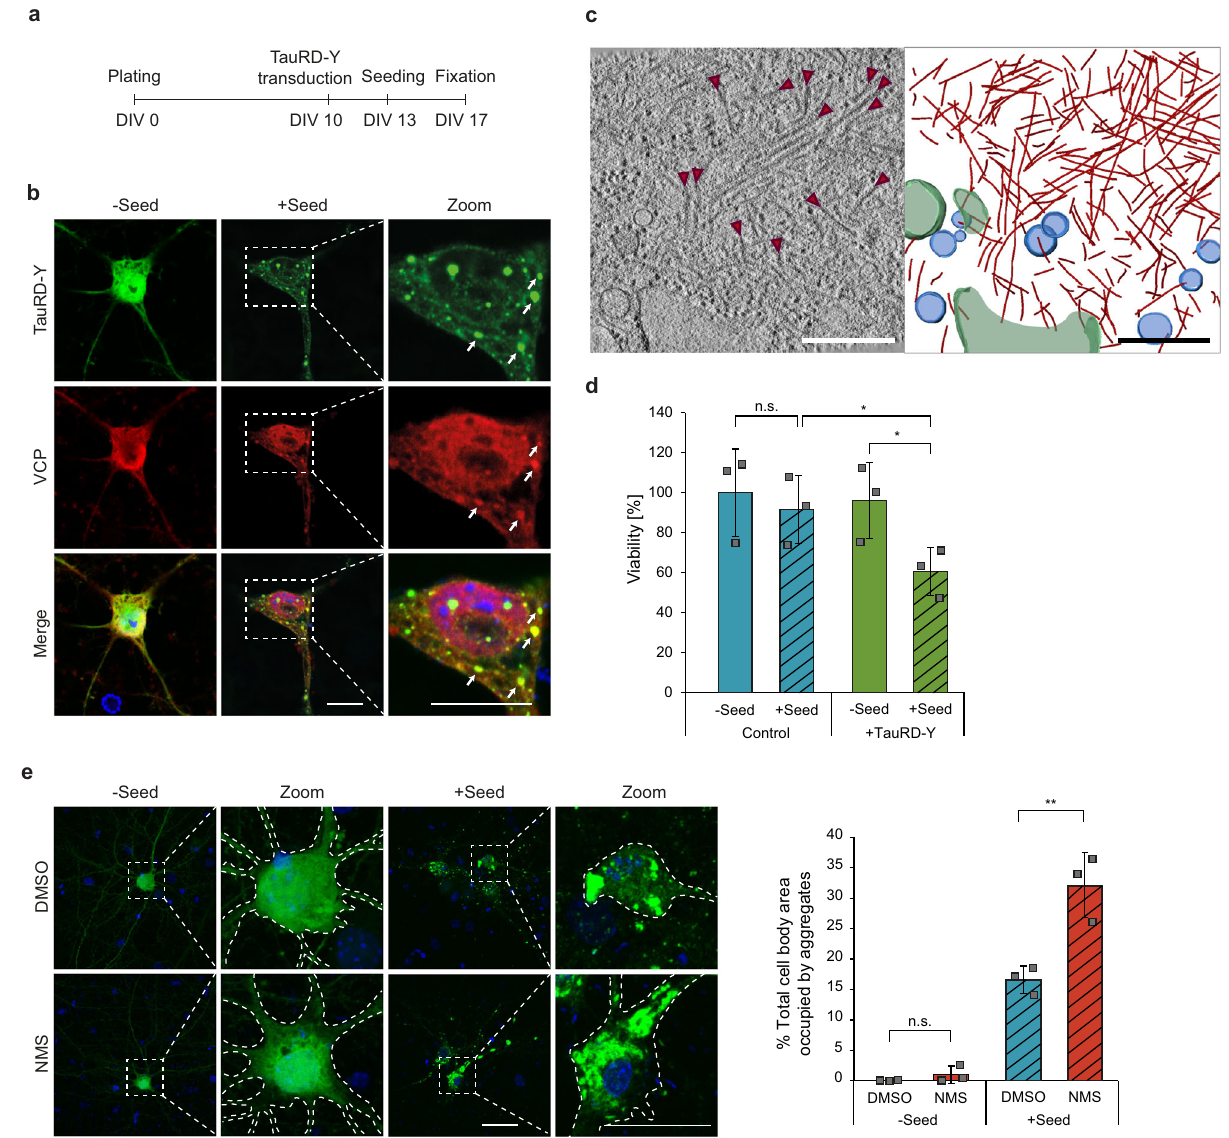
Fig.3|DisaggregationofTauRD-Yaggregatesinprimaryneuronsisdependent on VCP activity. a Schematic representation of experimental timeline in primary neurons.DIV,daysinvitro. b AssociationofVCPwithTauRD-Yinclusionsinprimary neurons. Immuno fl uorescence staining of VCP (red) and YFP fl uorescence of TauRD-Y (green). Arrows point to TauRD-Y inclusions containing VCP. Repre- sentative images from three independent experiments are shown. Scale bars, 10 µ m. c Fibrillar TauRD-Y aggregates in primary neurons. Left, a 1.4nm thick tomographic slice of a TauRD inclusion from neurons is shown. Red arrowheads indicate TauRD-Y fi brils. Right, 3Drendering of corresponding tomogramshowing TauRD-Y fi brils (red), vesicles (blue), and ER (green). A representative tomogram from two independent experiments is shown. Scale bar, 350nm. d Toxicity of TauRD-Y aggregation in primary neurons. Untransduced neurons or neurons